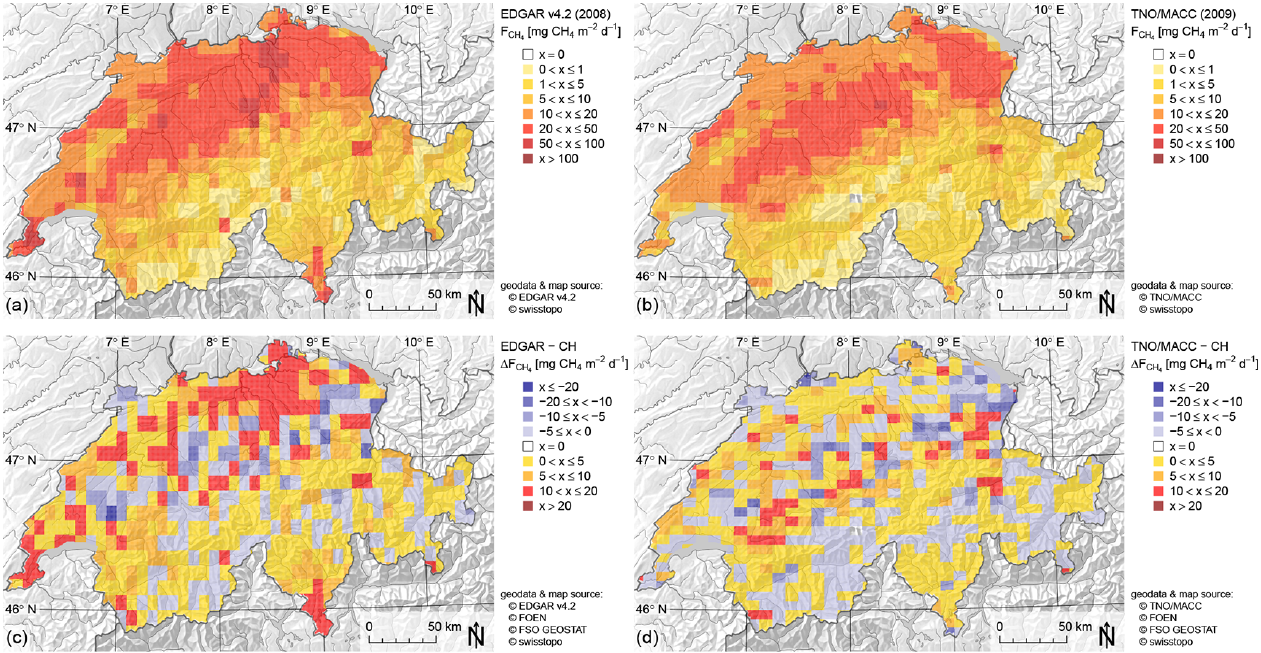
Fig. 3. Total anthropogenic CH 4 emissions over Switzerland according to the EDGAR v4.2 inventory for the year 2008 (a) and the TNO/MACC inventory for the year 2009 (b) . Panels (c) and (d) are absolute differences from the total anthropogenic emissions in our inventory (Fig.